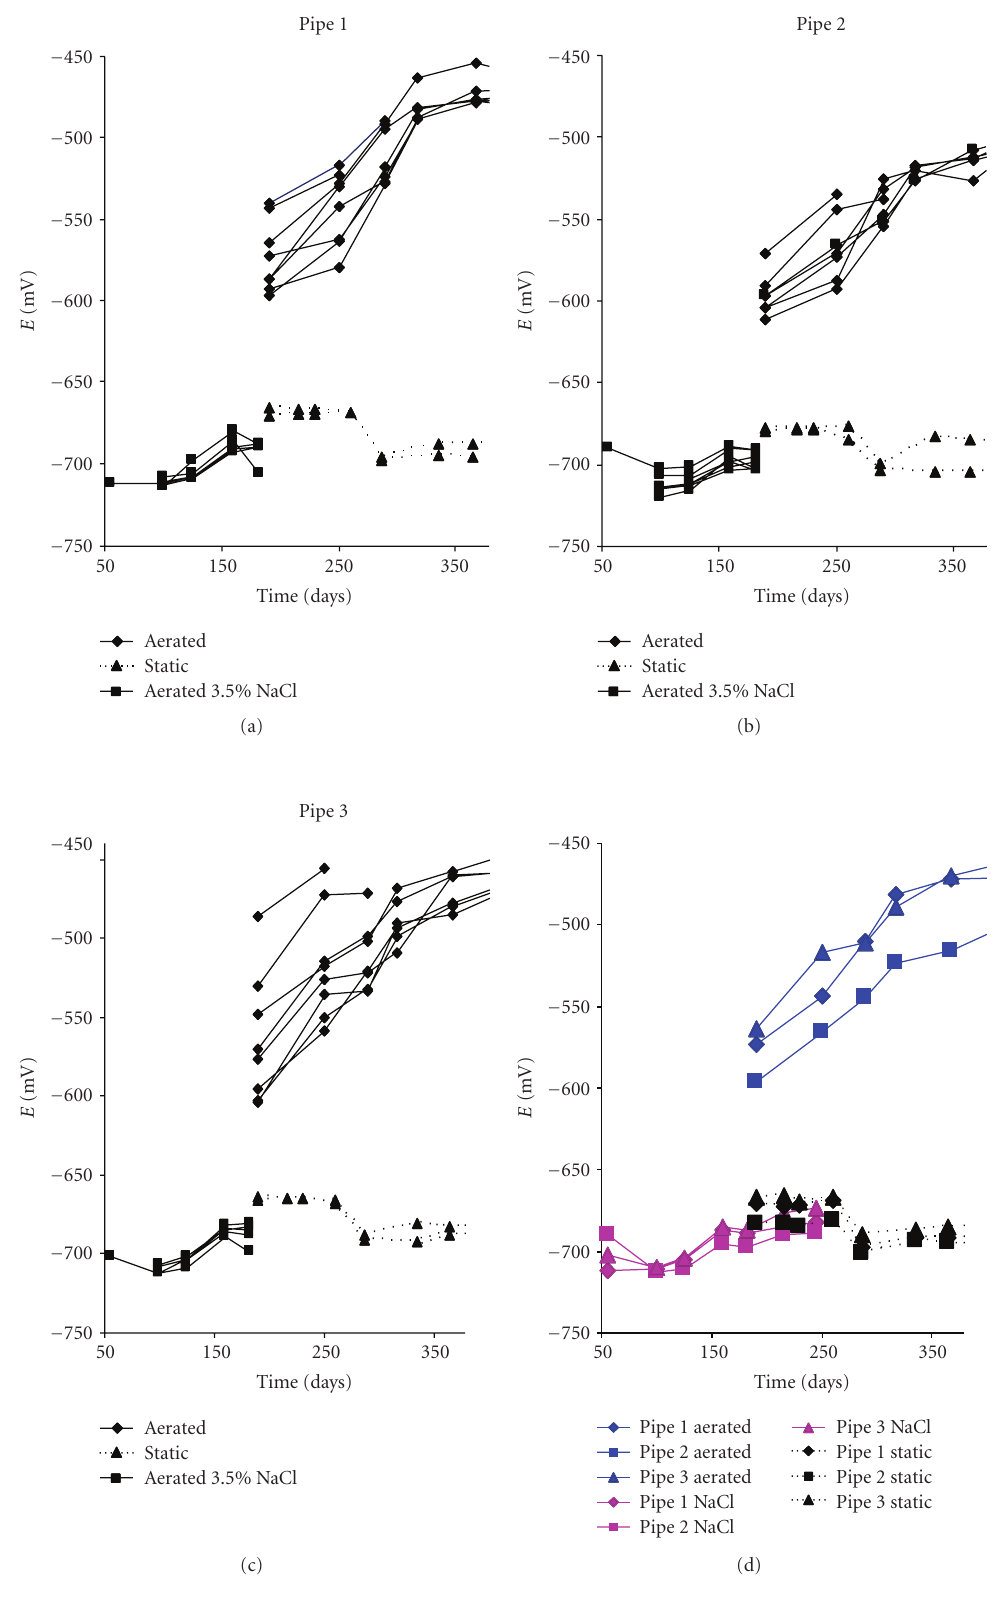
Figure 10: Open circuit potential for Pipes 1–3 in di ff erent